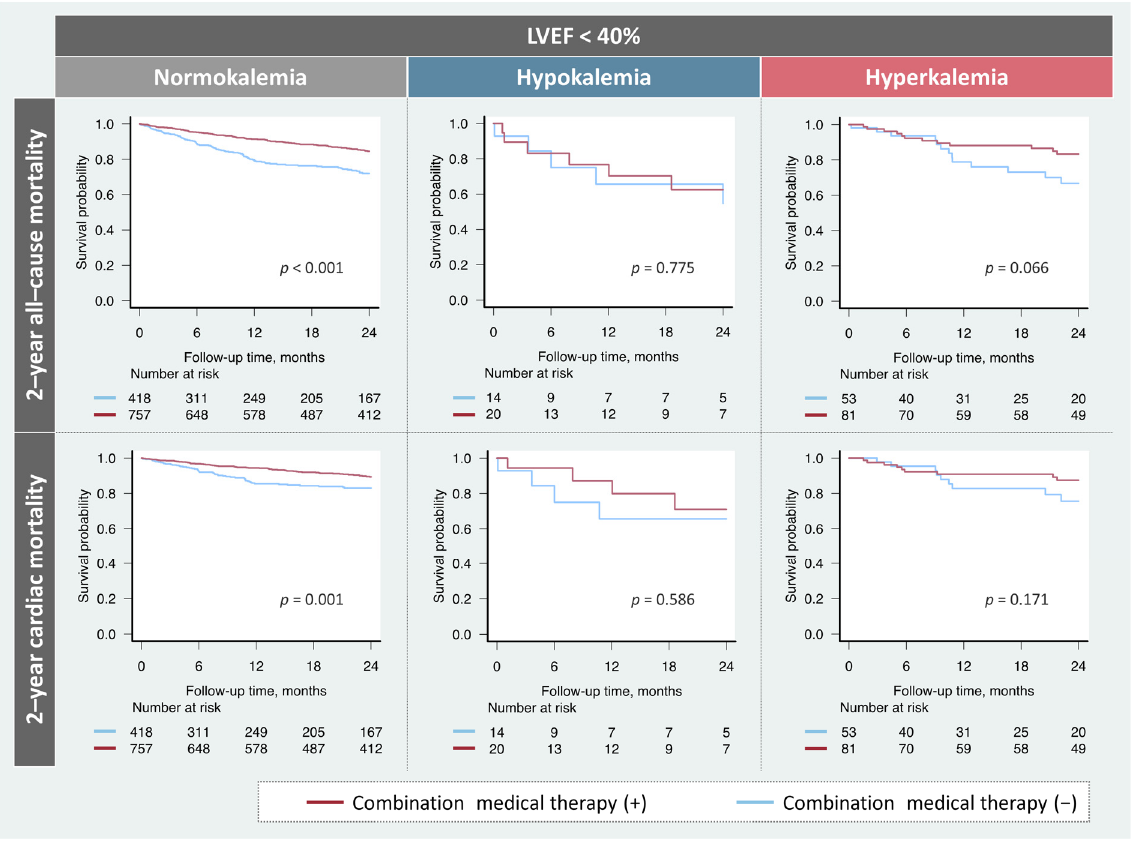
Figure 3. Impact of the combination medical therapy on prognosis based on potassium levels. Combination medical therapy was significantly associated with a favorable prognosis in patients with normokalemia. However, these findings were not observed in patients with hypokalemia. LVEF, left ventricular ejection fraction.